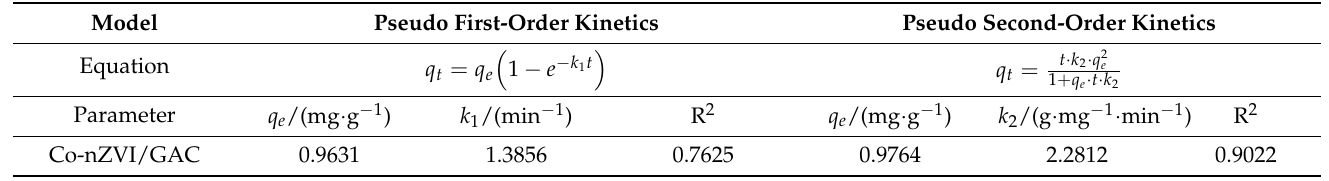
Table 2. Fitting parameters of kinetics equation of PNP adsorption by Co-nZVI/GAC activated PS. Model Pseudo First-Order